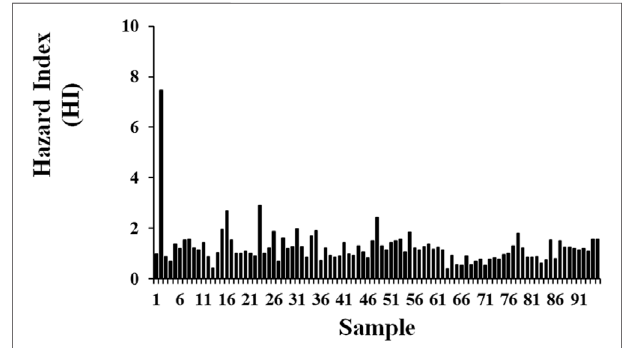
FIGURE 4 | HI per sample of metal residues in the edible tissue of C. bellicosus from the NAV complex, Mexico.